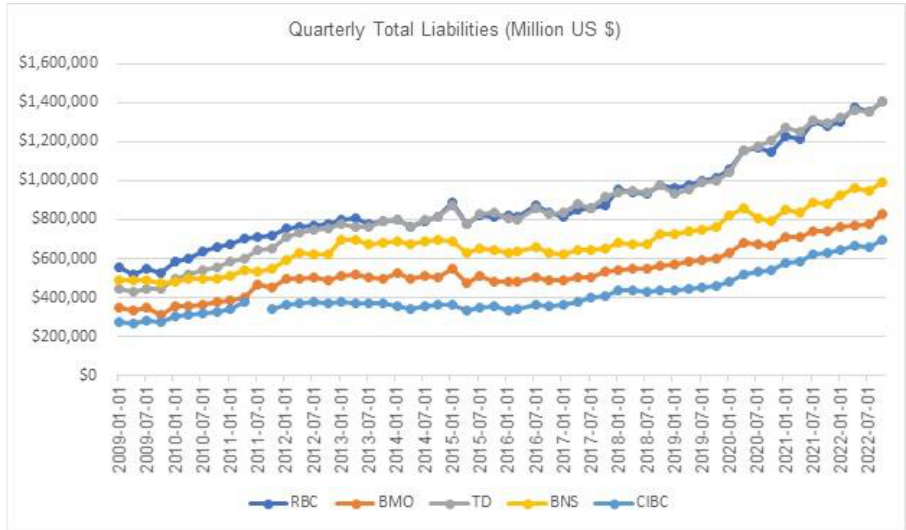
Figure A1. Quarterly total liabilities of the five banks (Source: Data 2 n.d. https://www.macrotrends.net/stocks/charts, accessed on 12 December 2022).